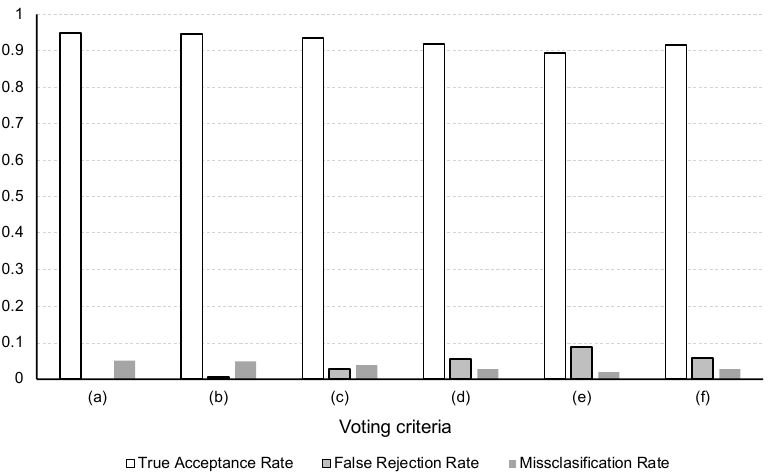
Figure 11. Experiment 2 results—voting criteria comparison: ( a ) First to plurality. ( b ) Plurality. ( c ) Wining by three votes. ( d ) Winning by six votes. ( e ) Winning by nine votes. ( f )